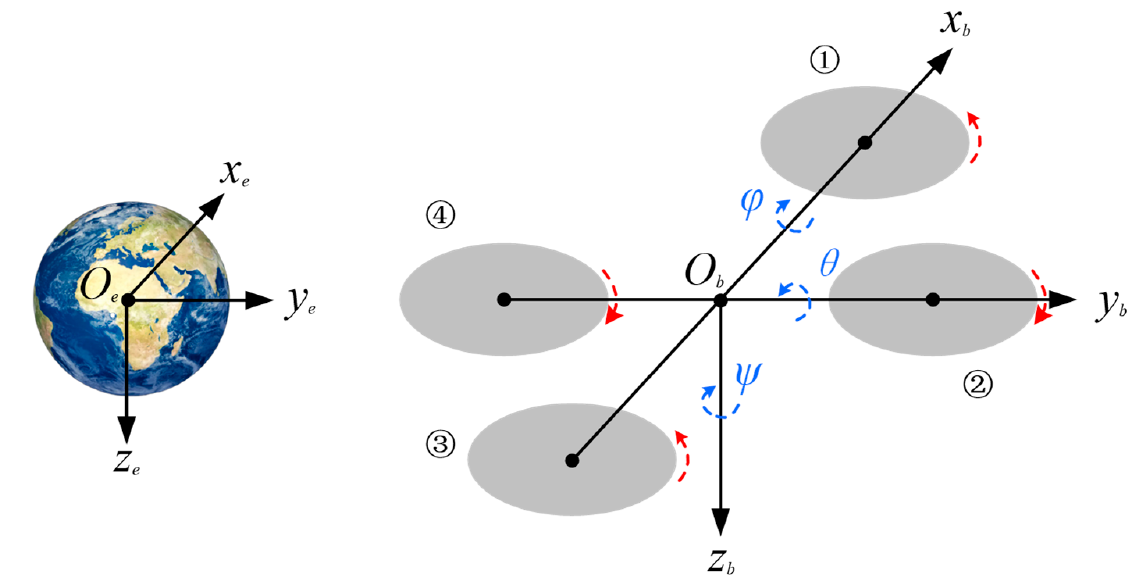
Figure 2. The Earth-centered, Earth-fixed coordinate system and body coordinate system: ① – ④ are propeller numbers, where ① and ③ are in the same direction, and ② and ④ are in the other direction.